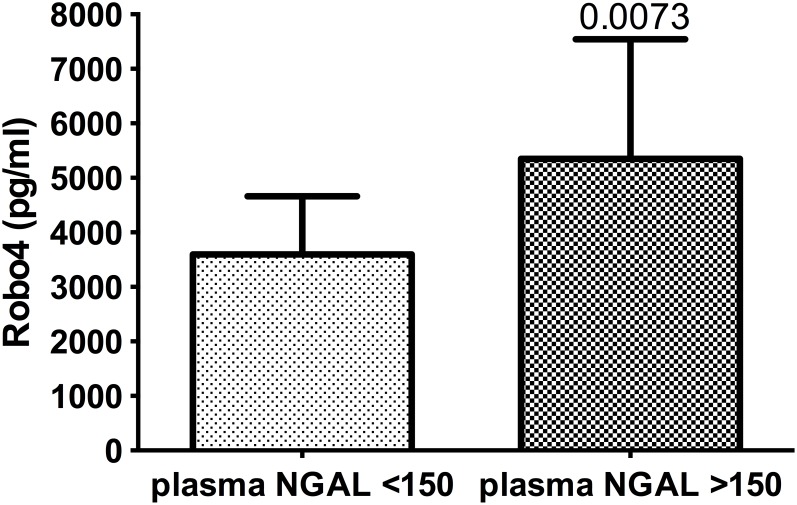
Plasma Robo4 levels in patients with or without AKI based on NGAL levels.Plasma levels of Robo4 in patients, 2 h post-cardiac surgery requiring cardiopulmonary bypass with or without acute kidney injury (AKI); assigned using plasma NGAL cut-off levels of 150 ng/ml. Data presented as bar graphs with mean and SD concentrations (pg/ml) of Robo4; n = 16 (AKI), n = 16 (non-AKI).